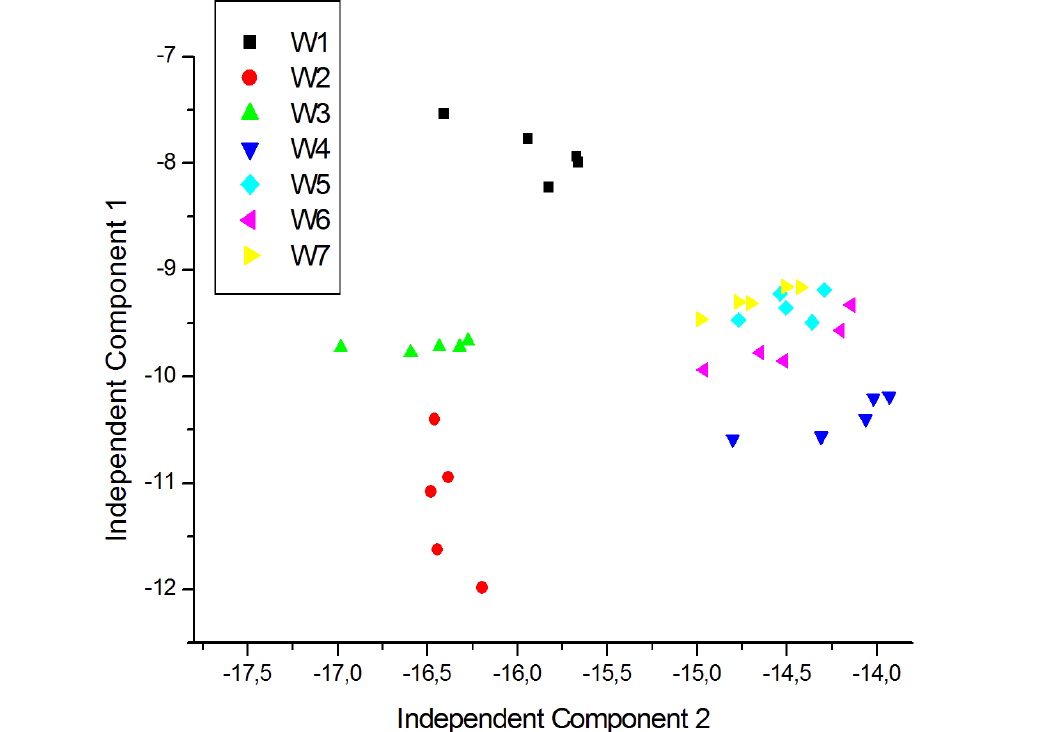
Figure 7. ICA plot of the young white wine